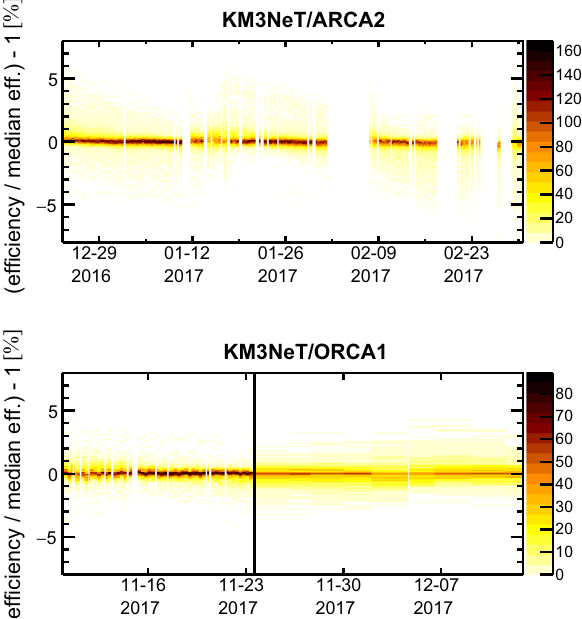
Fig. 4 Deviation of the estimated photon detection efficiency for each PMT with respect to its global median efficiency for the ARCA2 and ORCA1 detectors as a function of time. The color scale indicates the number of PMTs in each bin. Vertical white bands reflect the periods without data-taking; the vertical black line represents the time at which the L1 data stream downscaling was introduced (see text)